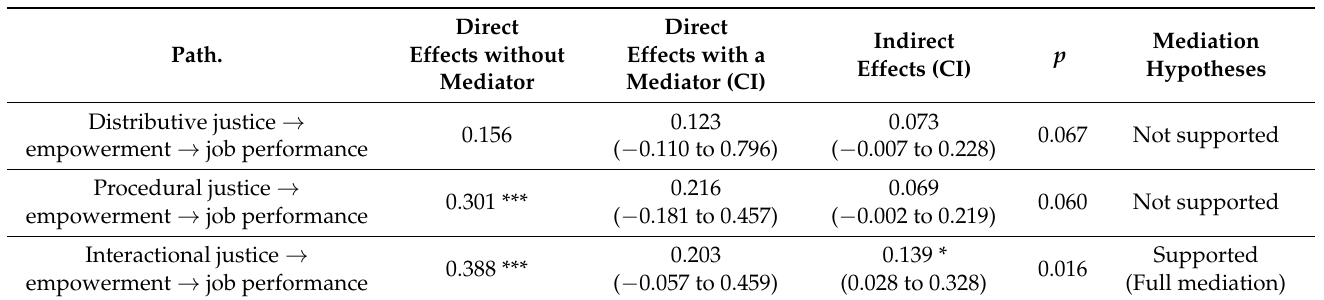
Table 4. Mediation